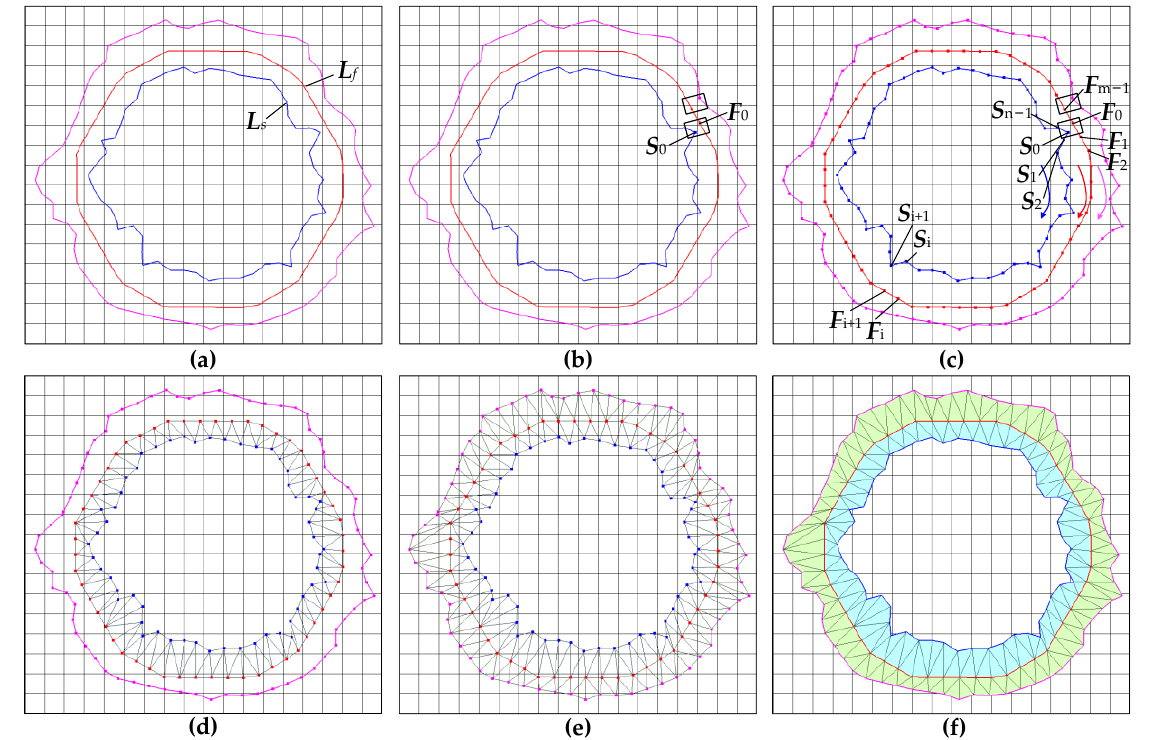
Figure 5. Remeshing between polylines. ( a ) shows the initial polylines. ( b ) shows the initial matched point. ( c ) shows the results of the preprocessing of polylines and alignment of the point column direction. ( d ) shows the results of matching the vertices of the first set of polylines based on the triangulation rules. ( e ) shows the results of matching the vertices of the second set of polylines based on the triangulation rules. ( f ) shows the solid model after re-meshing.